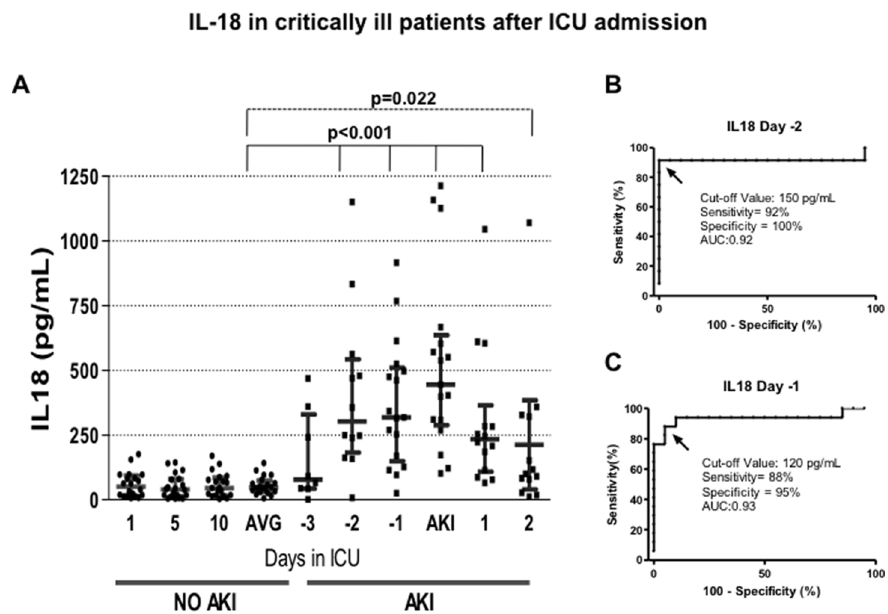
levels in no-AKI patients determinated at 1, 5, and 10 days after ICU admission. B) Specificity and sensitivity of IL-18 to detect AKI two days before the AKIN criteria, determined by ROC analysis. C) Specificity and sensitivity of IL-18 to detect AKI one day before the AKIN criteria, determined by ROC